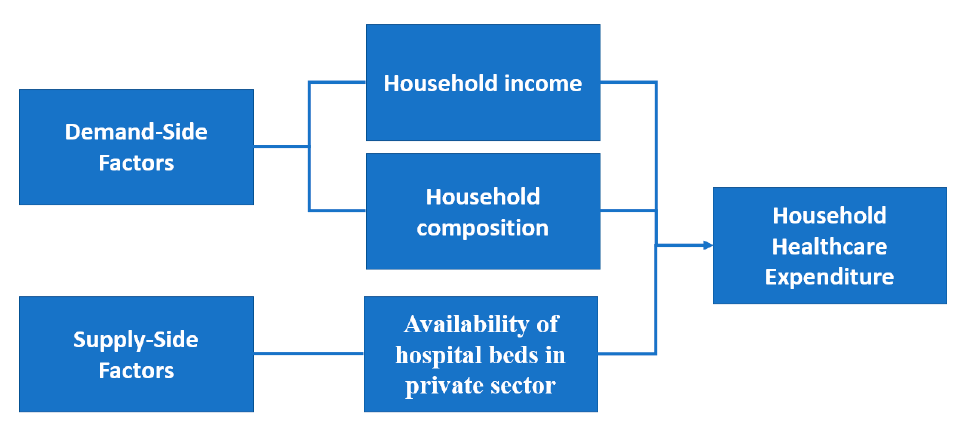
Figure 5. Conceptual Framework.